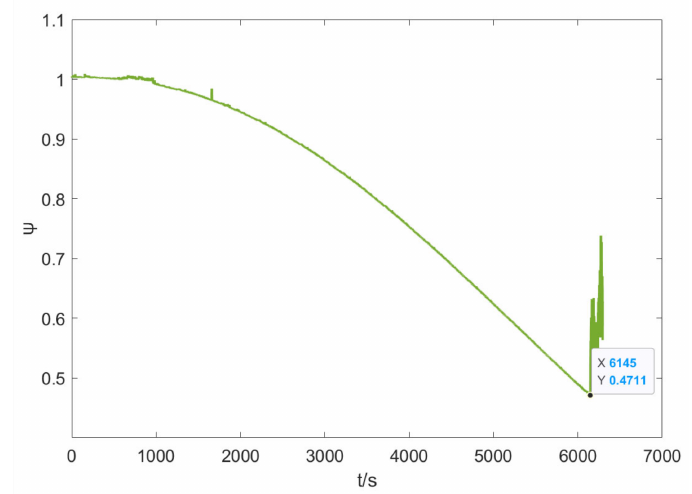
Figure 8. Variation relationship between variable ψ and time.